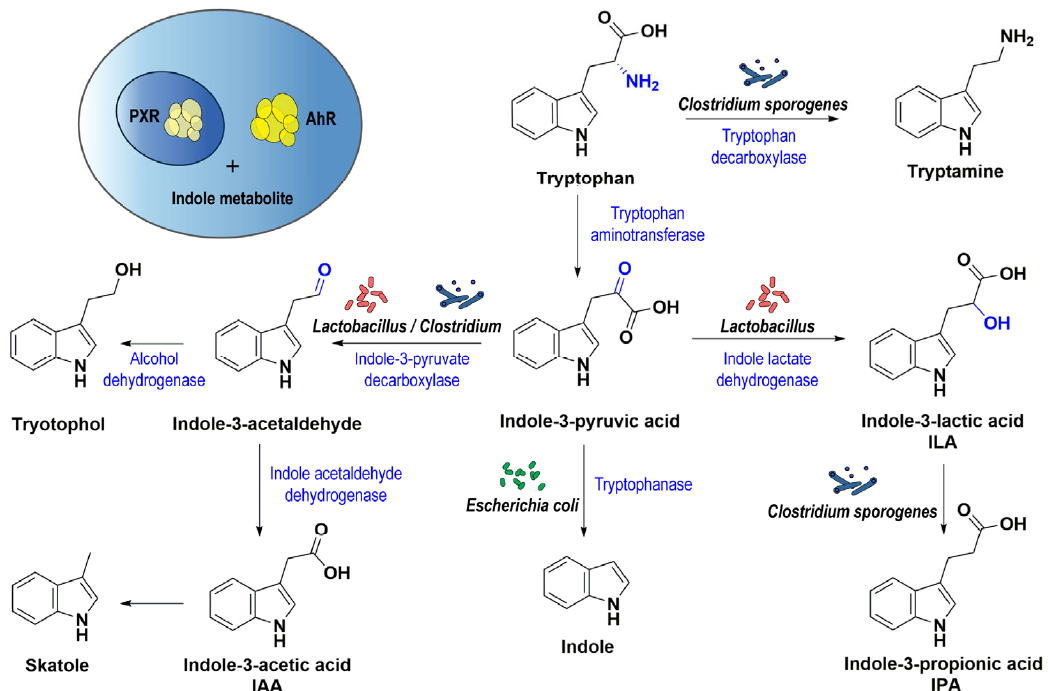
Figure 1. Production of indole metabolites by gut microbiota and its corresponding enzymes. Indole metabolites bind to intracellular or cytoplasmic transcription factor PXR or AhR, respectively, and activate their corresponding pathway. Tryptophan is transformed into different indole metabolites via microbial enzymes (blue color) present in specific gut microorganisms. Abbreviations: AhR: aryl hydrocarbon receptor; PXR: pregnane X